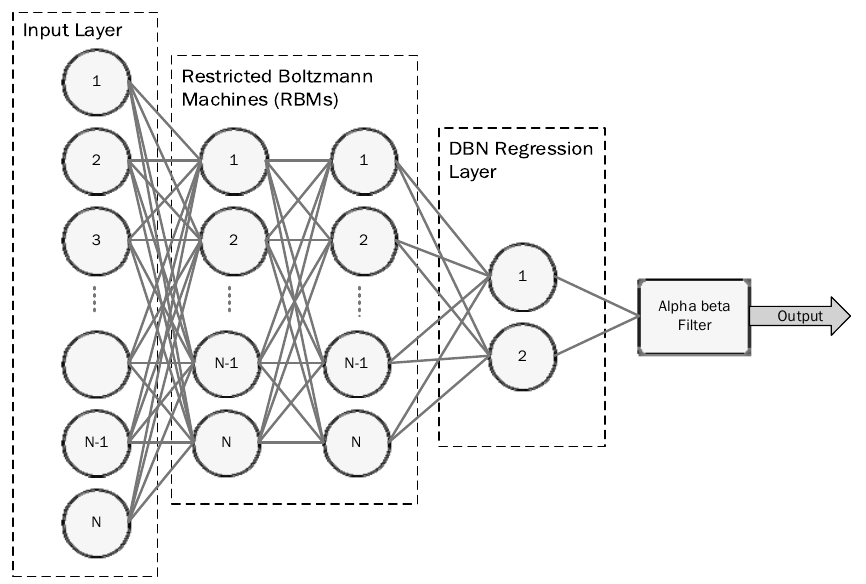
Figure 3. The structure model of deep belief network with alpha-beta filter.